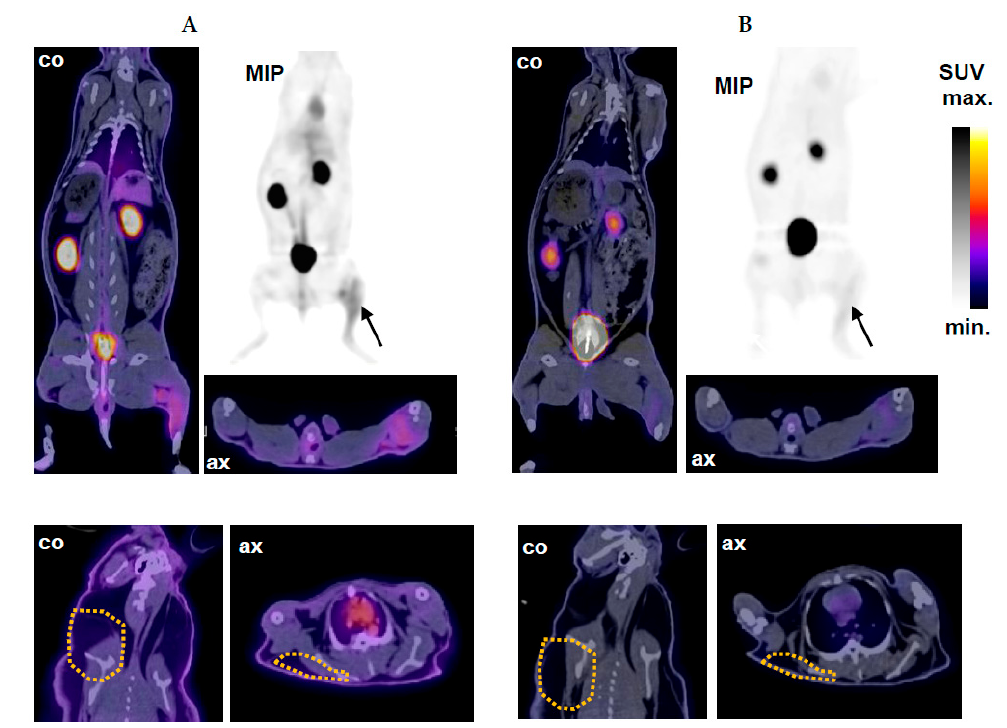
Figure 5. PET/CT imaging of NZR3 at ( A ) 5 min and ( B ) 60 min after injection of 68 Ga-DOTA-TBIA101. Top panel: the MTB infection was successfully delineated by the tracer. Arrows highlight the infection site in a representative midplane-coronal (co) and axial (ax) PET/CT slice and in a maximum intensity projection (MIP) PET image. Bottom panel: A viable staphylococcal infection site in the scruff area (yellow-dotted lines) was not localized by PET/CT imaging as presented in coronal (co) and axial (ax) PET/CT slices.